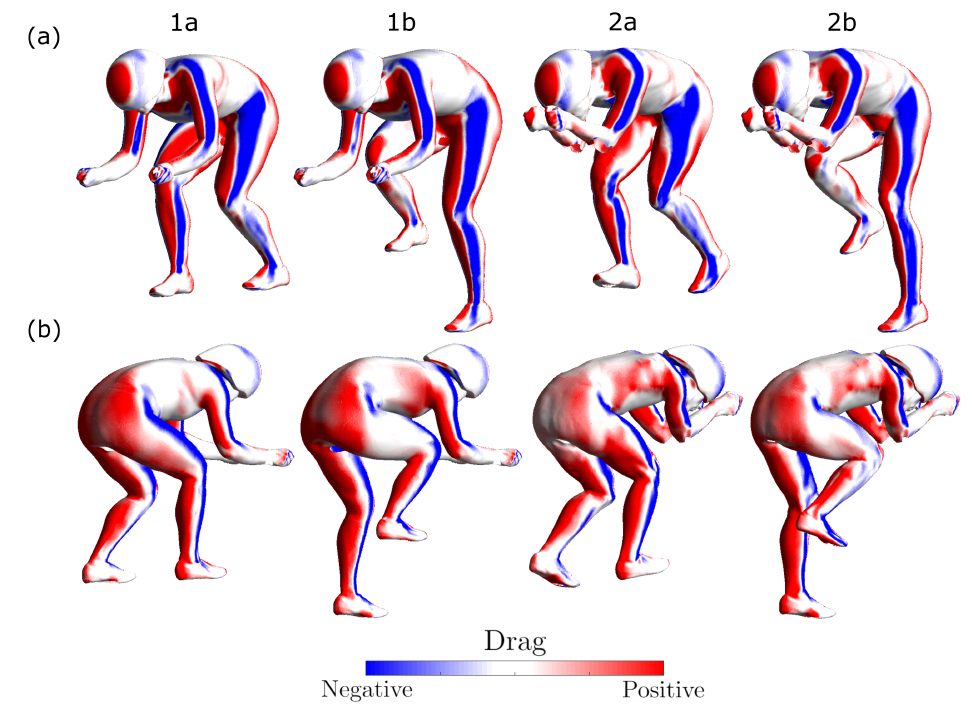
Figure 6. Comparison of local drag per unit area distribution over the riders: ( a ) isometric view from the front; ( b ) isometric view from the